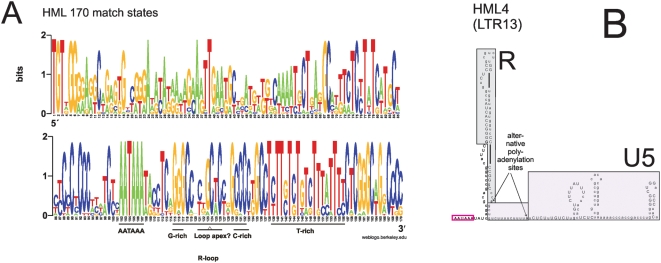
Outcome of the HML HMM.A. Weblogo for a Viterbi alignment of the HML training set (“hml”). Conventions are as in Fig 1. B. The HML4/LTR13 RU5 RNA sequence [55] analysed with the HML HMM, and folded with MFOLD (Fig S2a). Match state positions are in upper case. R boundaries, with alternative polyadenylation sites [55], are shown. AATAAA is boxed in red.